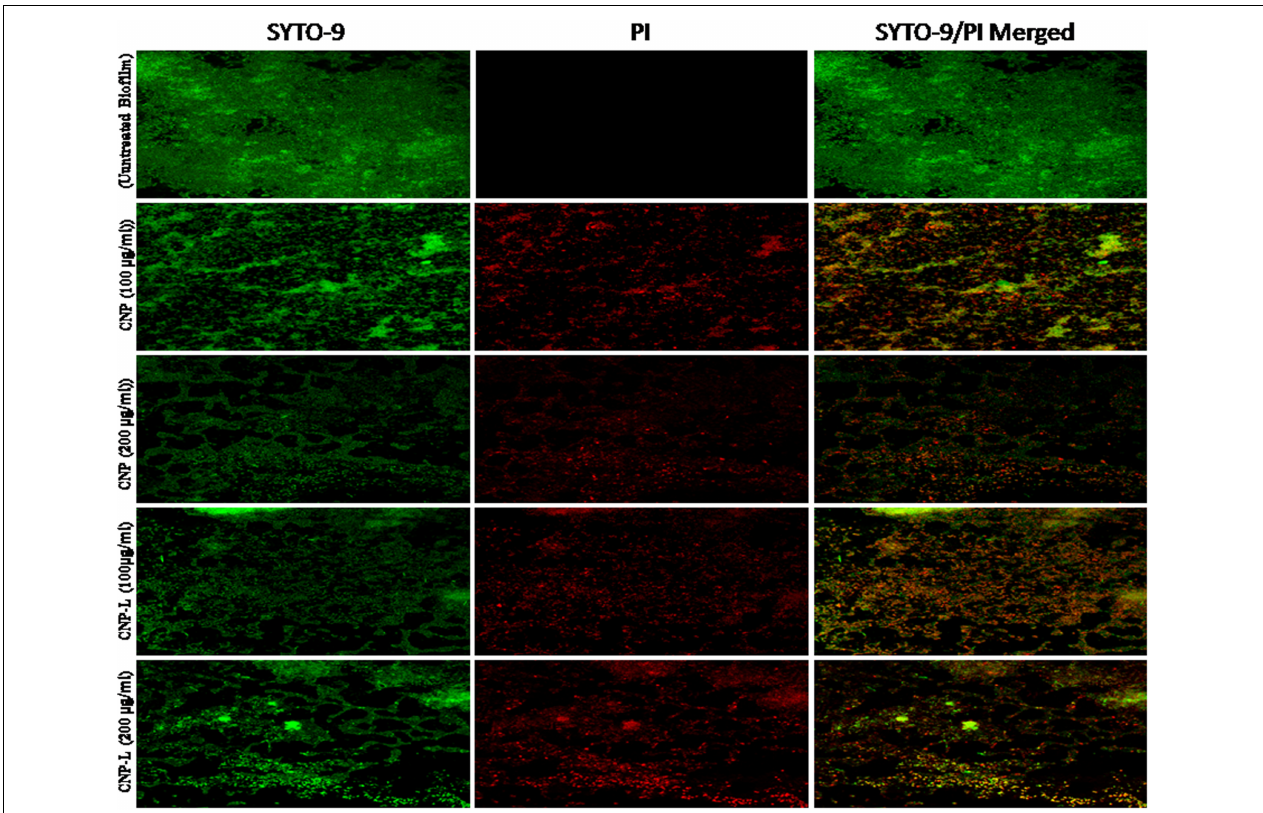
FIGURE 5 | Confocal microscope image showing M. smegmatis biofilm inhibition by CNPs as visualized in 63X oil immersion magnification: anti-biofilm activity of CNPs was assessed by incubating M. smegmatis with increasing concentrations of CNPs for 36 h in a six-well plate. The treated biofilm was stained with SYTO-9/PI. The addition of increasing concentration (100–200 µ g/ml) of CNPs inhibited M. smegmatis biofilm formation. Red-dye showing PI-stain corresponds to killing activity, and Green dye showing viable bacteria in pre formed biofilm. Yellow color corresponds to co-localization of merged green and red dye at same